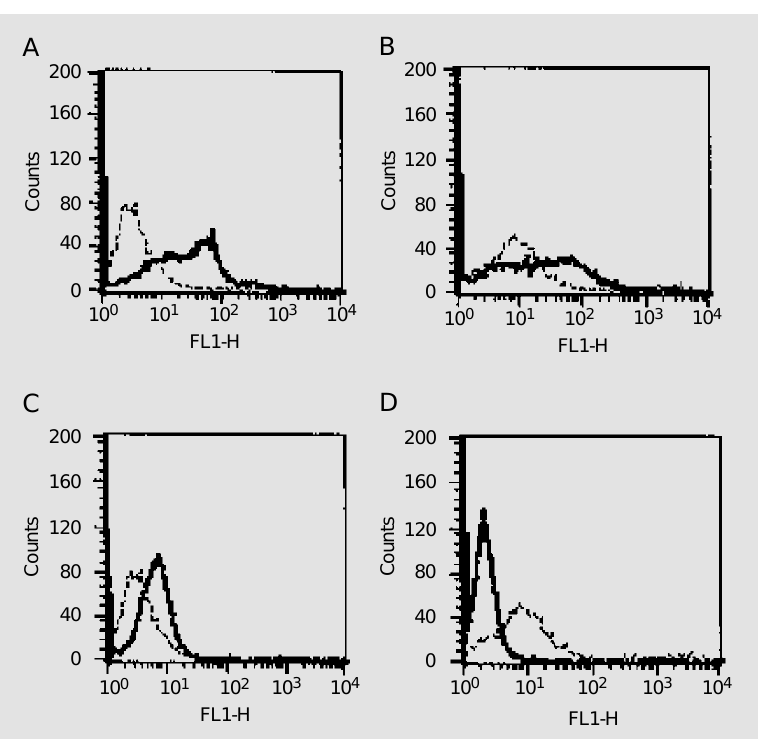
Figure 3. Carcinoembryonic antigen (A and B) and desmoglein (C and D) expression on the cell surface of the two clones, analyzed by flow cytometry using specific antibodies (solid lines). LISP-A10 (A and C), LISP-E11 (B and D). Dashed lines represent the negative control (normal mouse purified IgG). FL1-H: fluorescence intensity. Figure 4. Adhesion of 5 x 10 4 cells from LISP-A10 (A) and LISP-E11 (B) cell clones in re- sponse to increasing concentra- tions of laminin, fibronectin or 1% BSA (control) adsorbed to the solid phase. The graphs show a representative result from four experiments. Error bars indicate the standard devia-